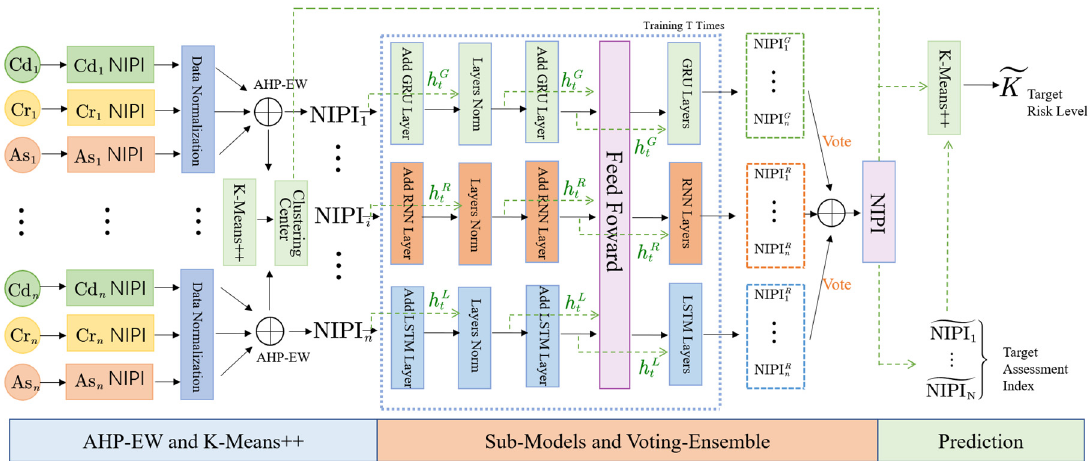
Figure 7. Overall architecture of the proposed voting-ensemble method (NIPI).